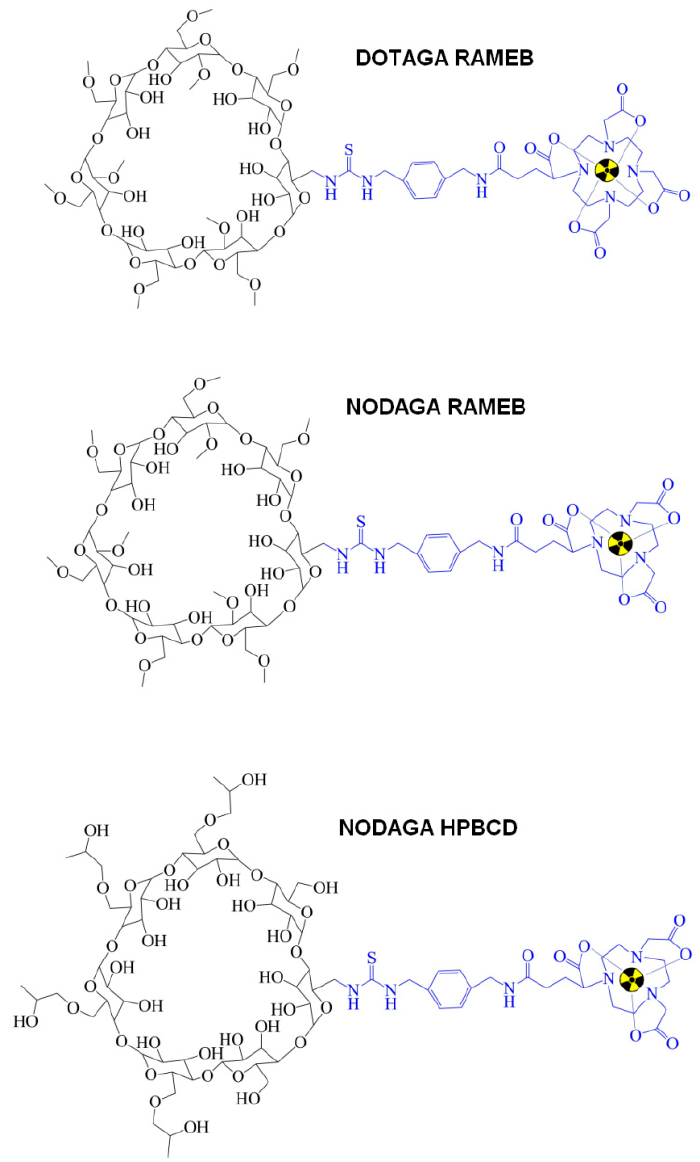
Figure 2. Chemical structure of CD-based PET radiopharmaceuticals. CD: cyclodextrin; PET: positron emission tomography.